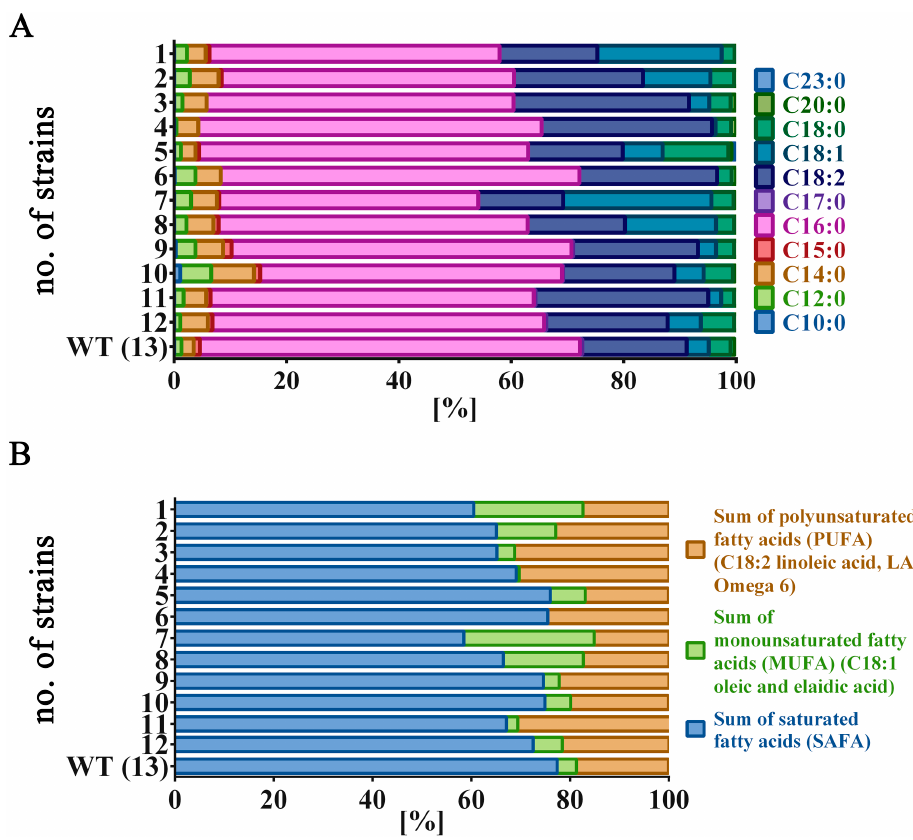
Figure 2. Fatty acid profiles of Planktochlorella nurekis strains (1–13). ( A ) distribution of fatty acids in biomass of individual Planktochlorella nurekis strains; ( B ) Major fatty acid groups of Planktochlorella nurekis strains (1–13): saturated fatty acids (SAFA), monounsaturated fatty acids (MUFA), poly- unsaturated fatty acids (PUFA). Percentage contents of FAs are shown.